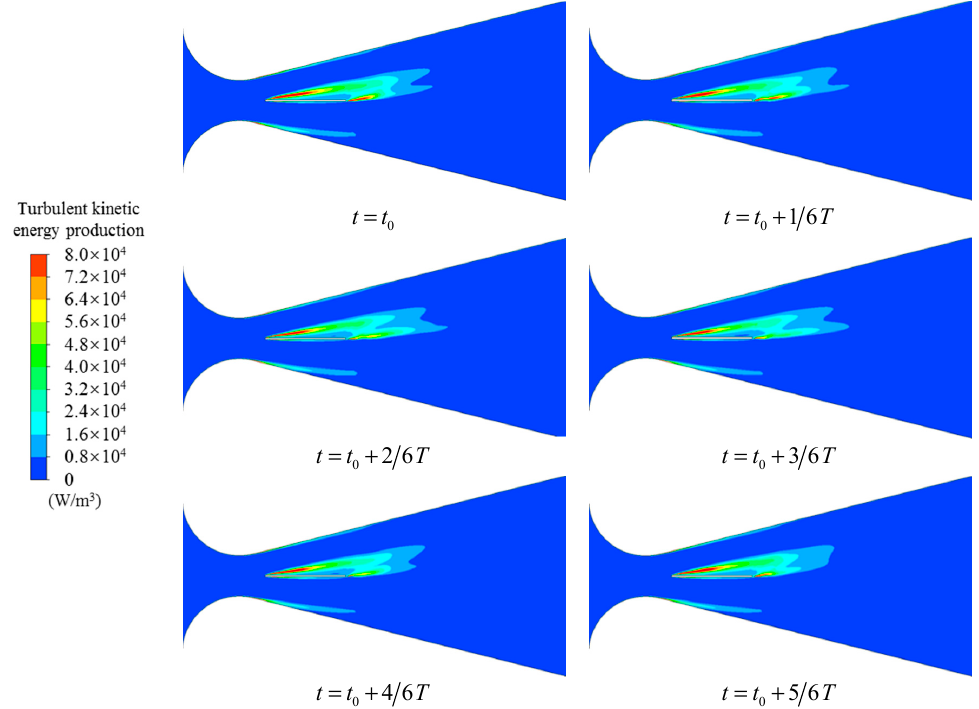
Figure 16. Distributions of turbulent kinetic energy production in vaned diffuser.